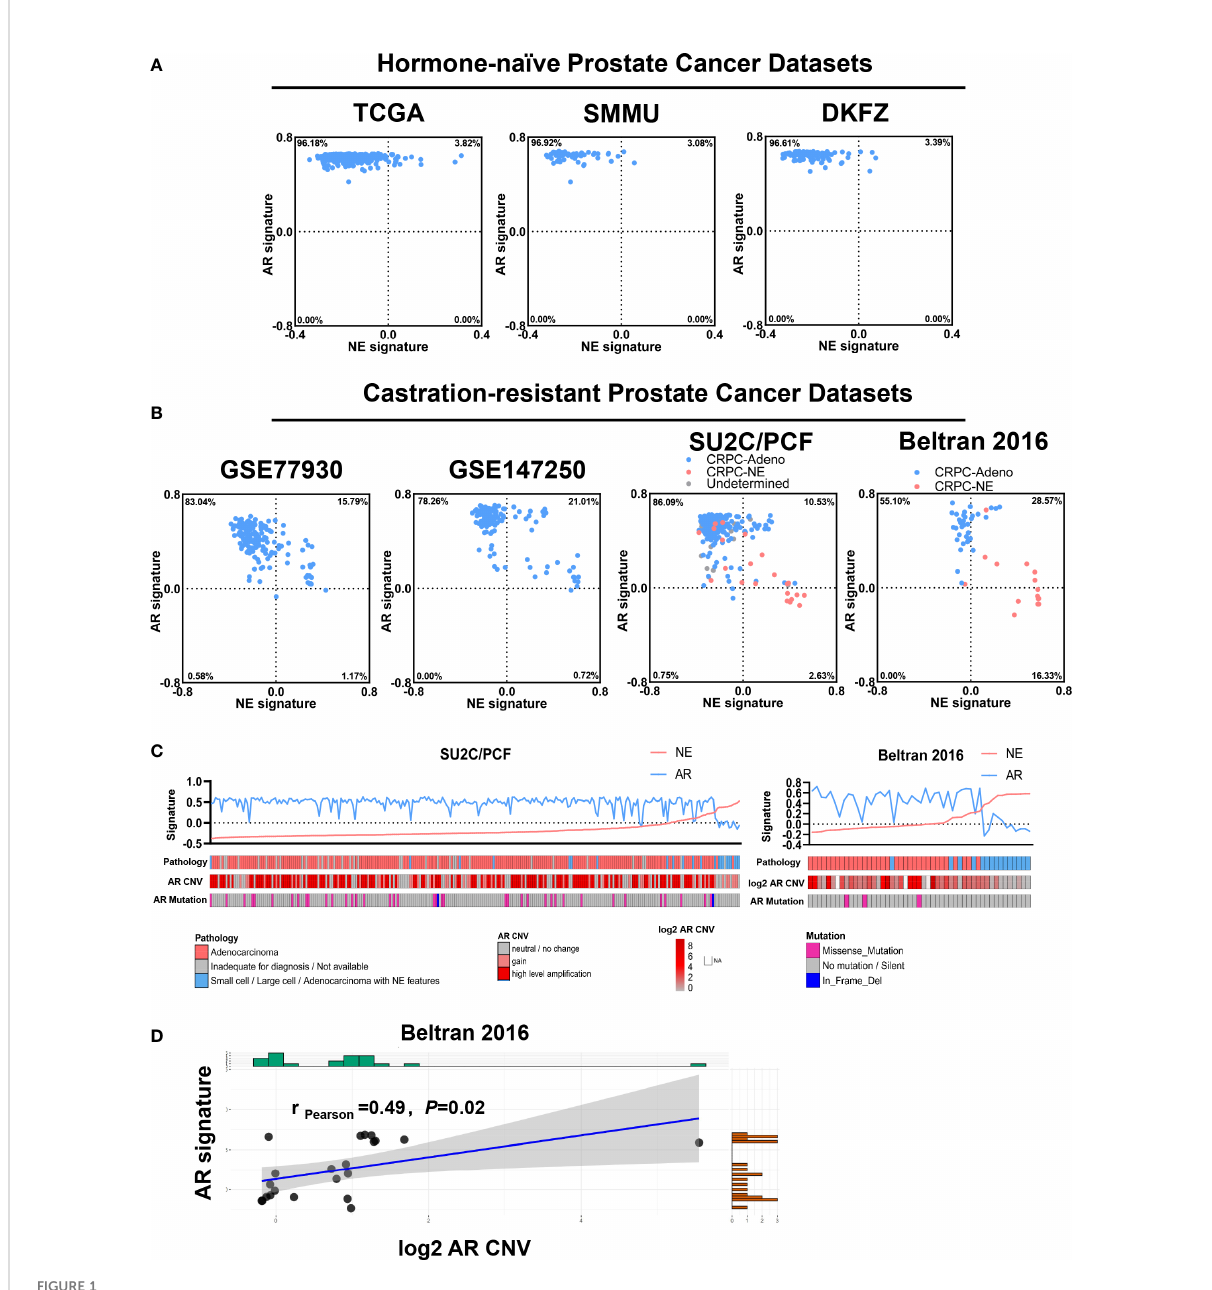
FIGURE 1 Comparative analysis of androgen receptor (AR)/neuroendocrine (NE)-associated genes in bulk prostate cancer transcriptome datasets. (A) Scatterplot showing the calculated AR and NE signature in hormone-naïve prostate cancer cohorts from The Cancer Genome Atlas ( n = 498), SMMU ( n = 65), and DKFZ ( n = 118). The blue points indicate pathology-con fi rmed adenocarcinoma without neuroendocrine features, and the red points indicate pathology-con fi rmed prostate cancer with neuroendocrine features. (B) Scatterplot showing the calculated AR and NE signatures in castration-resistant prostate cancer cohort from GSE77930 ( n = 171), GSE147250 ( n = 138), SU2C/PCF ( n = 266), and Beltran 2016 ( n = 49). The blue points indicate pathology-con fi rmed adenocarcinoma without neuroendocrine features, the red points indicate pathology-con fi rmed prostate cancer with neuroendocrine features, and the gray points indicate prostate cancer with undetermined pathology classi fi cation. (C) Top: plot reporting NE signature (red line) and AR signature (blue line) across cases in the SU2C/PCF and the Beltran 2016 cohorts. Cases were ordered by increasing the values of NE signature within each cohort. Bottom: annotations or heat map showing the pathology classi fi cation, AR copy number variation, and AR mutation status of each case. (D) Correlation between AR signature score and log2 AR copy number variation across the NE HIGH cases from the Beltran 2016 cohort. The shadow area indicates the 95% con fi dence interval. Pearson ’ s correlation coef fi cient and P -value are shown on the